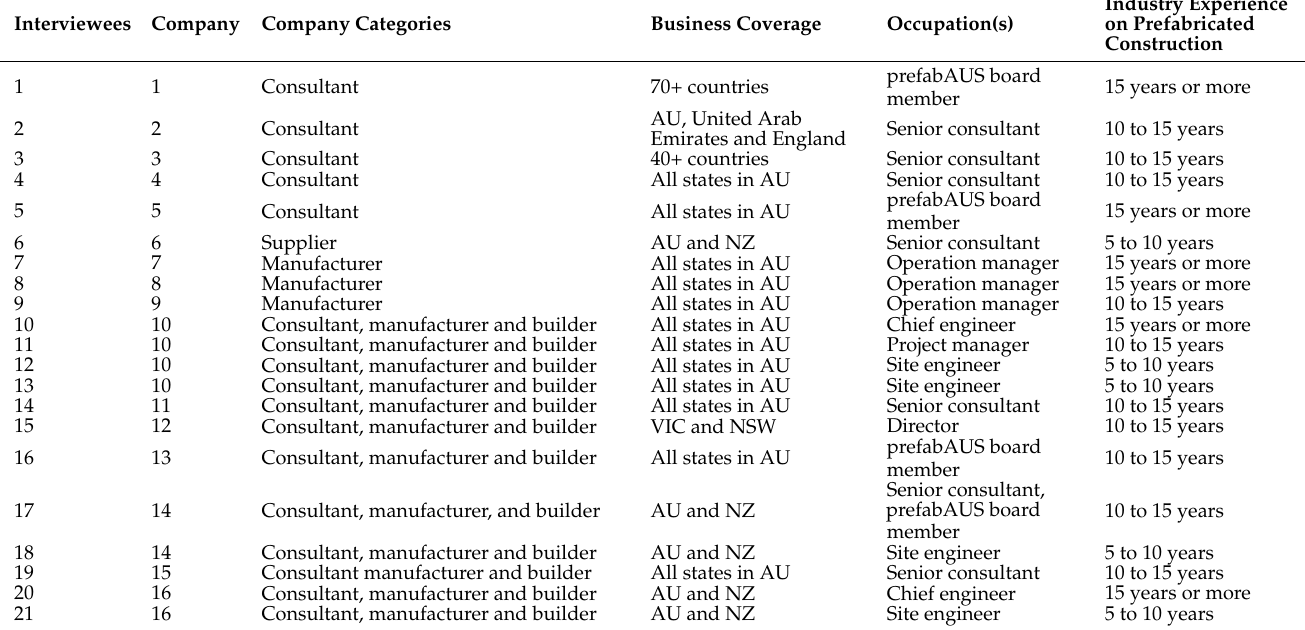
Table 1. Information sheet of interviewees.